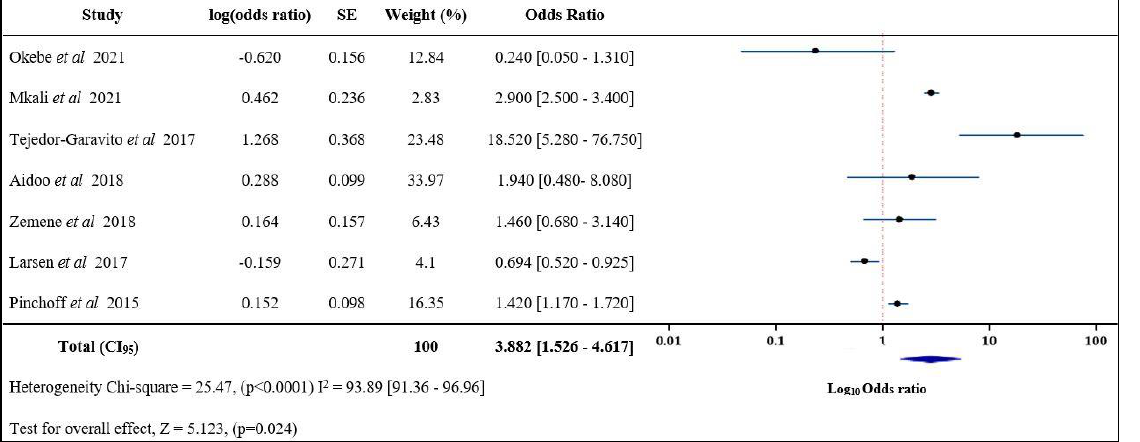
Figure 4. Risk of malaria infection in individuals living with an index case < 5 years old [15, 20, 37, 43, 47, 51, 62].